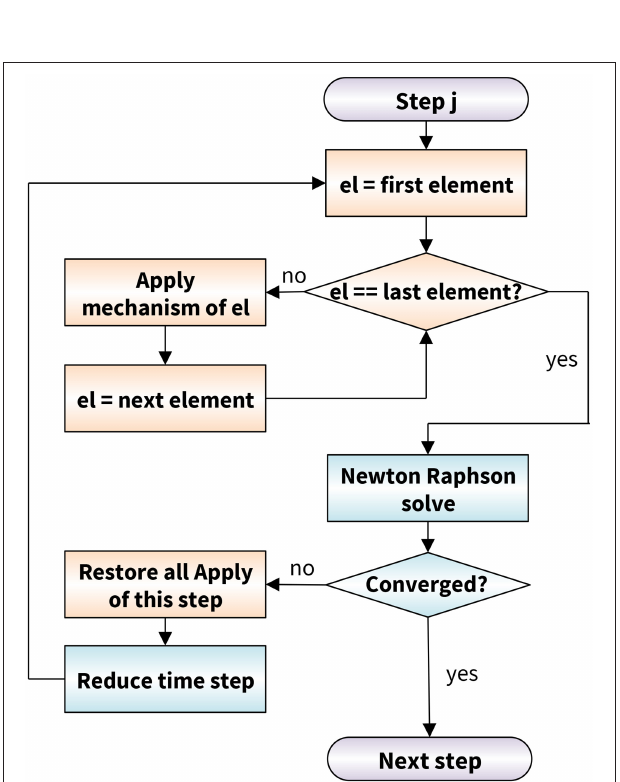
FIGURE 3 | Axon model flowchart based on a conventional Newton-Raphson solver (blue) modularly enhanced by the application of mechanisms (orange). At the beginning of each Newton-Raphson step, we apply the mechanism to each crosslink element. In case the algorithms does not converge, we restore the last equilibrium state of all mechanisms and reduce the time step